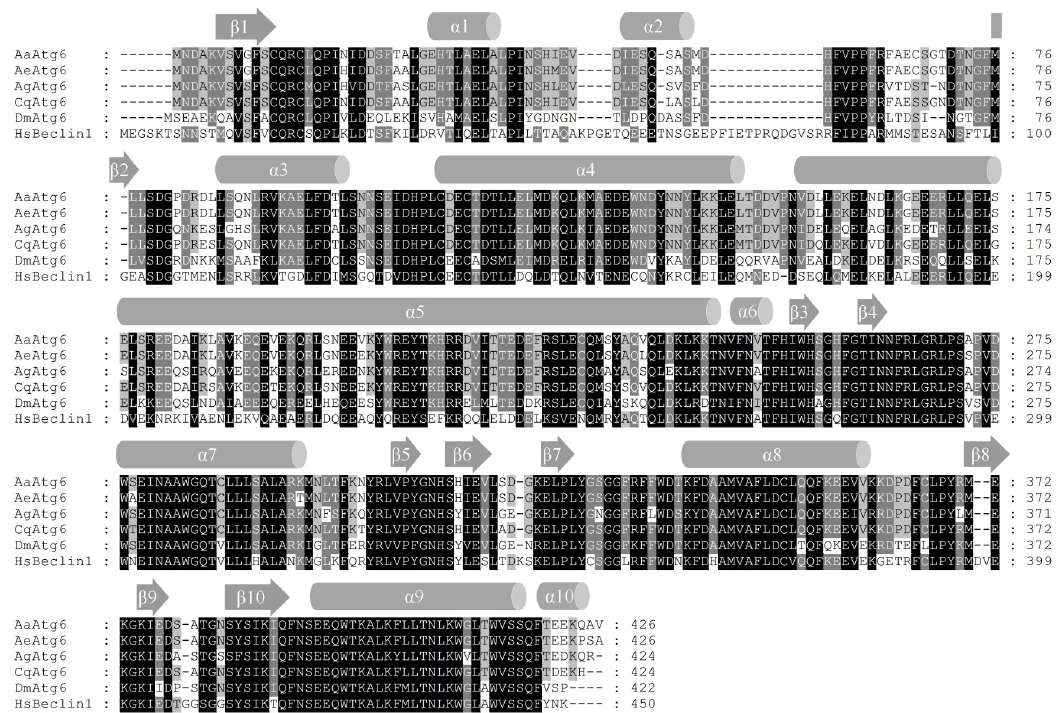
Fig 1. Sequence analysis of AaAtg6. The amino acid sequence of AaAtg6 was shown in alignment with Atg6 orthologs from Aedes aegypti (AeAtg6, NCBI: XP_001654535.1), Anopheles gambiae (AgAtg6, NCBI: XP_310418.5), Culex quinquefasciatus (CqAtg6, XP_001861442.1), Drosophila melanogaster (DmAtg6, NCBI: NP_651209.1) and Homo sapiens (HsBeclin1, NCBI: NP_001300927.1). The alignment was performed by using ClustalX 2.1 and modified by GeneDoc 3.2. The amino acid residues identical among 6, 5 and 4 or 3 orthologs were indicated by white letters within black boxes, white letters within dark gray boxes, and black letters within light gray boxes, respectively. Secondary structures were predicted using PSIPRED 4.0. α : alpha helices; β : beta